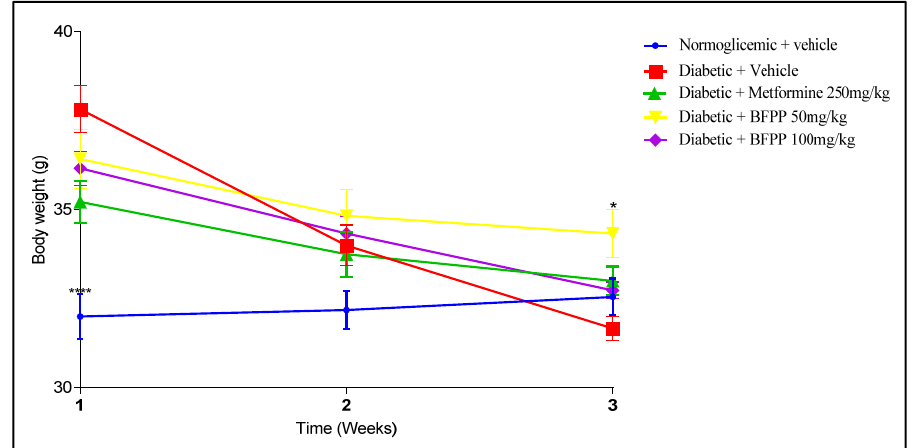
Figure 3. Effects of BFPP on body weight of mice with induced diabetes. Normoglycemic (blue), vehicle (red), metformin 250 mg/kg (green), BFPP 50 mg/kg (yellow), BFPP 100 mg/kg (purple). The data are expressed as mean ± SEM. Two-way ANOVA post-test Bonferroni. * p ≤ 0.05 and **** p ≤ 0.0001 compared with the vehicle